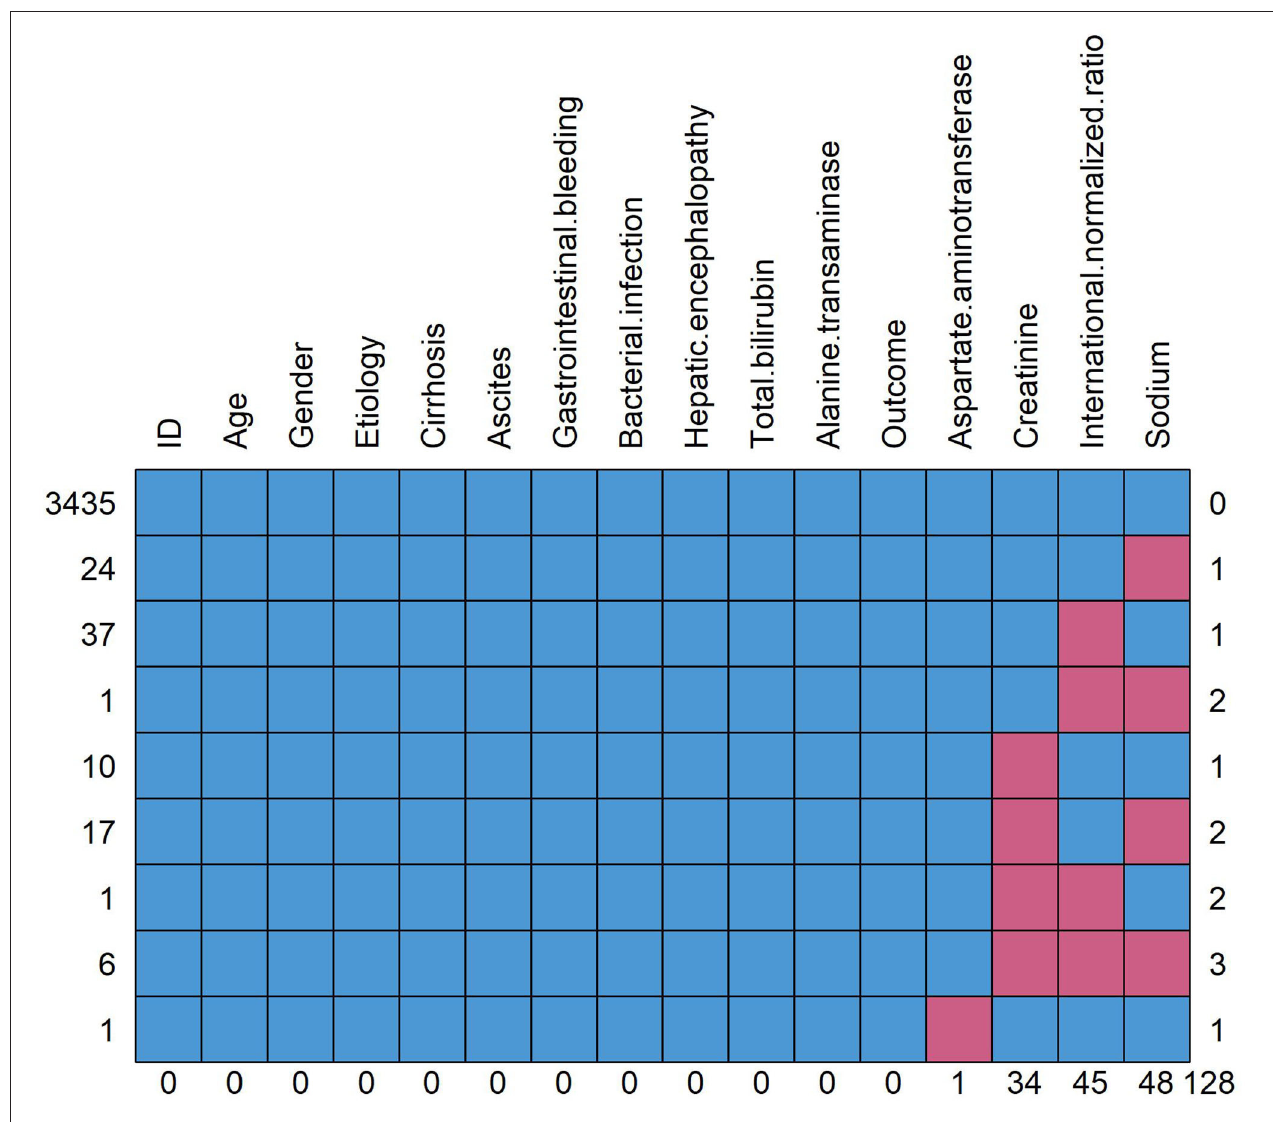
FIGURE 2 | Pattern of missing data. The red square means data missing and the blue square means data complete. The figure shows the overall number of missing data for each variable and the distribution of different missing types. Taking the “sodium” in the rightmost column as an example, a total of 48 patients have missing data of sodium, of which 24 patients (line 2) have missing data of sodium alone, 1 patient (line 4) has missing data of international standardized ratio and sodium, 17 patients (line 6) have missing data of creatinine and sodium and 6 patients (line 8) have missing data of creatinine, international normalized ratio and